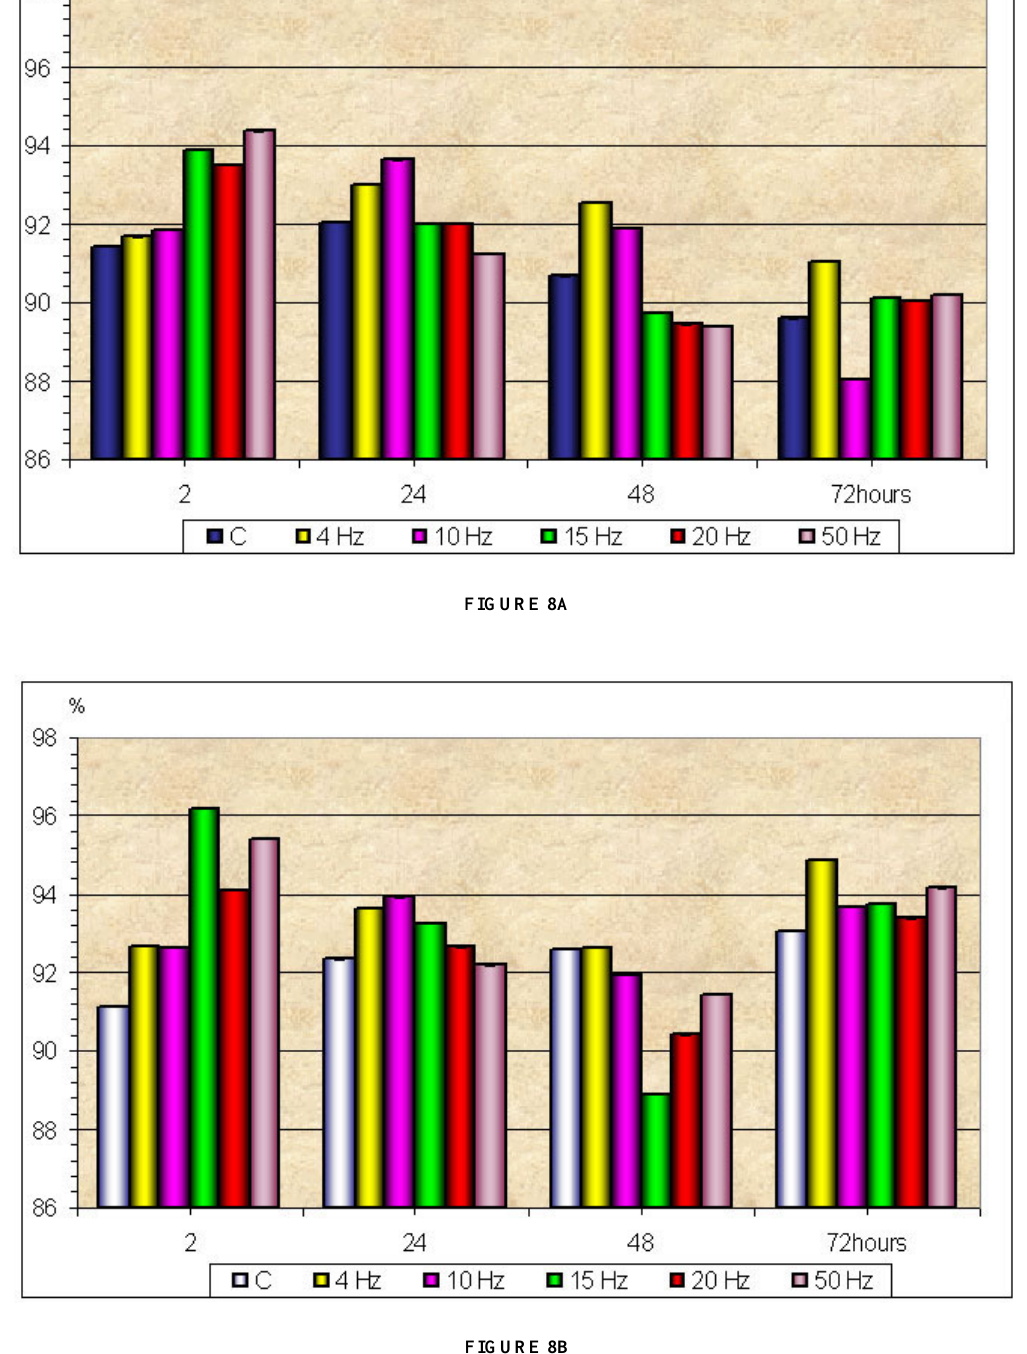
FIGURE 8. The effect of nontreated (control) and ELFV-pretreated DW on the changes of seed dry weight during 72-h incubation. (A) Seed dry weight at room temperature (20 o C), (B) seed dry weight in cold (4 o C) DW. On abscissa, the time (in hours) of seed incubation; on ordinates, percent of seed dry weight changes compared to its wet weight 0